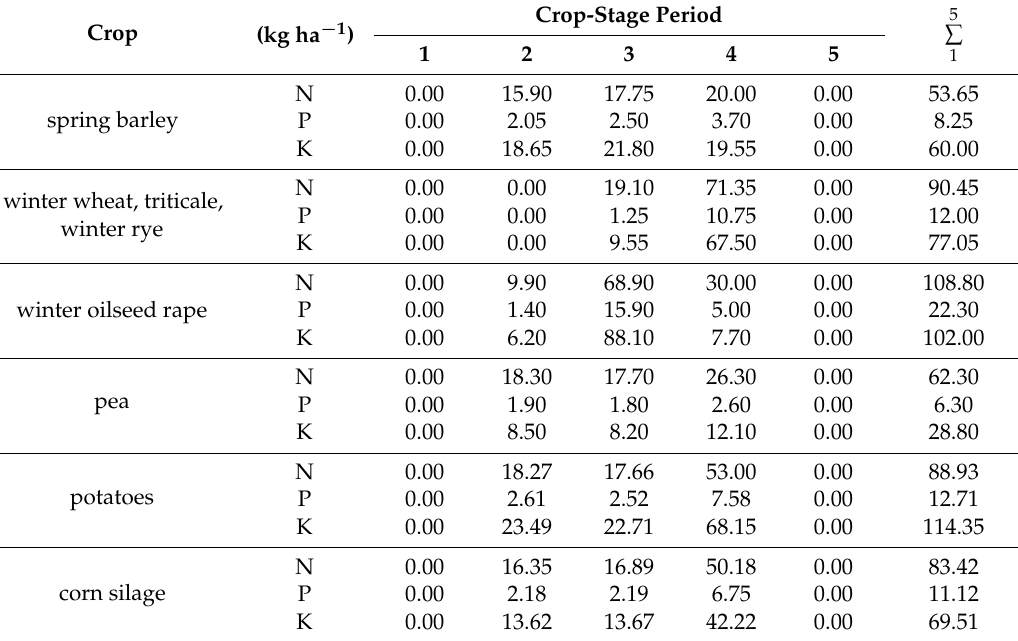
Table 4. Proposed partial and average plant nutrient uptake during the crop-stage periods.